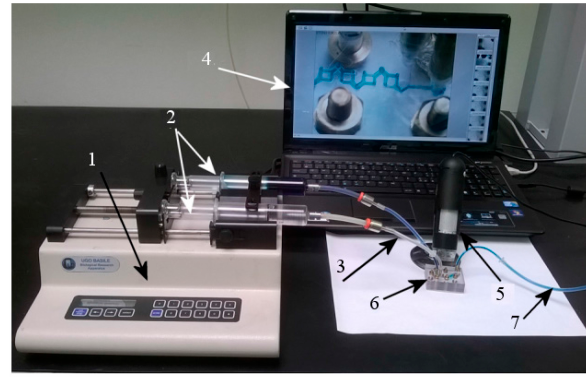
Figure 4. Experimental setup.